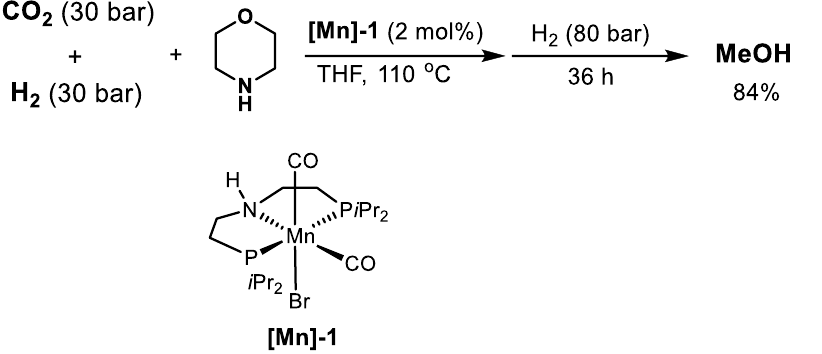
Figure 14. Manganese complexes catalyzed hydrogenation of CO 2 .